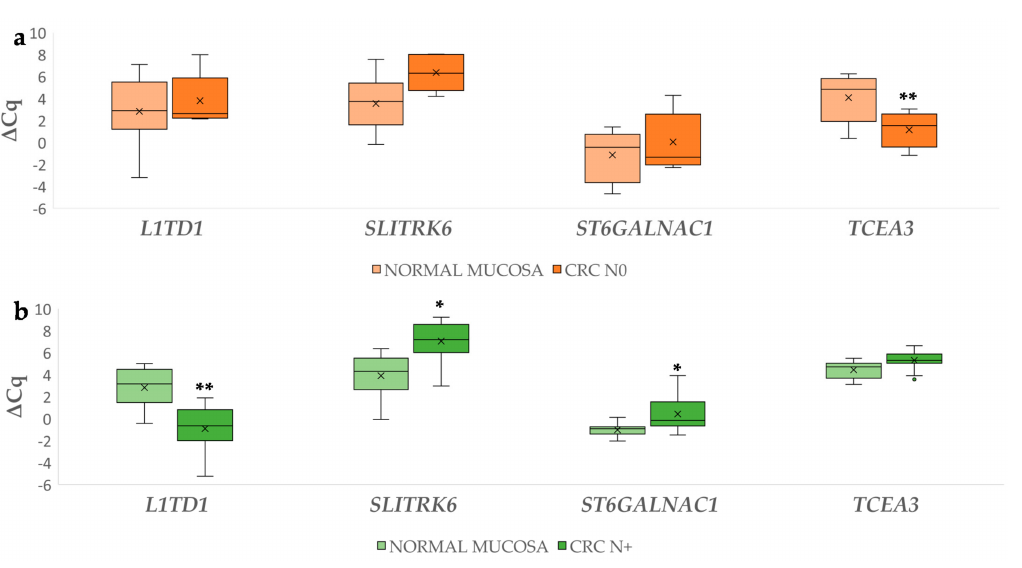
Figure 3. Expression ( ∆ Cq) of the investigated genes in carcinoma without ( a ) and with lymph node metastases ( b ) and corresponding normal mucosa. Legend: CRC N0, colorectal carcinoma without lymph node metastases; CRC N+, colorectal carcinoma with lymph node metastases; x, mean; ◦ , outlier; * p ≤ 0.05; ** p ≤